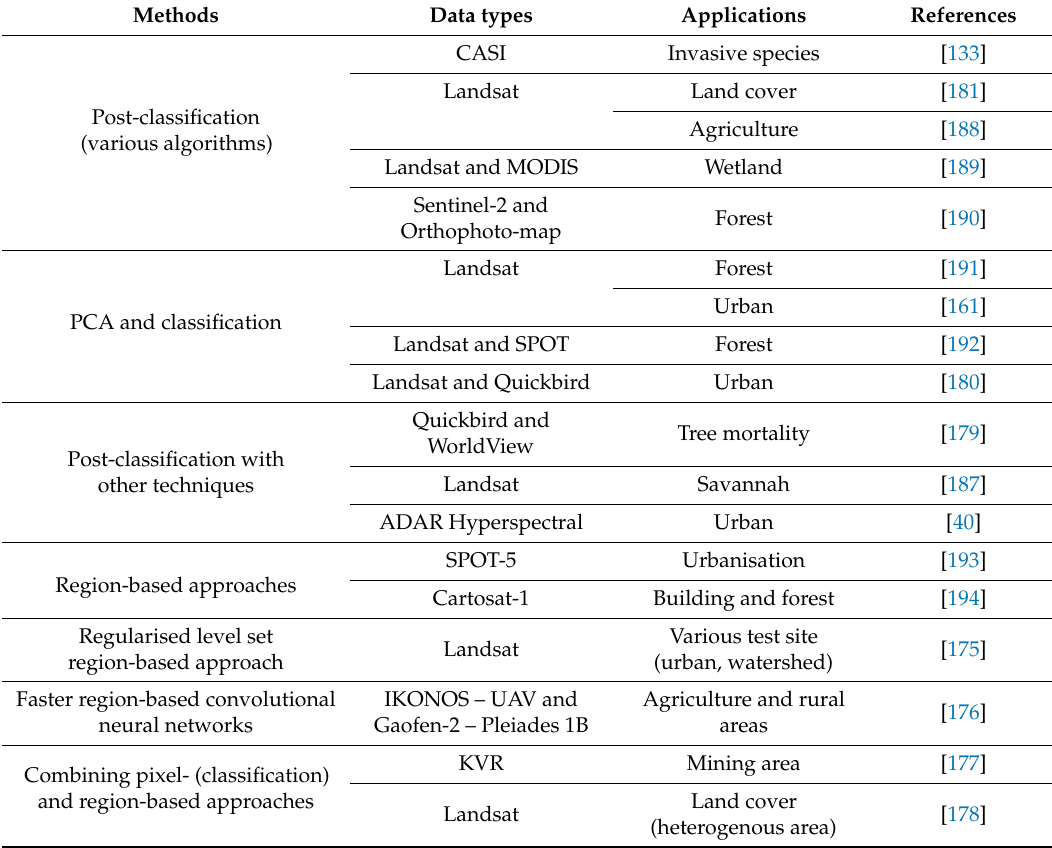
Table 2. A non-exhaustive list of methods, data source, and ecosystem applications of research that generates type or composition of change information.